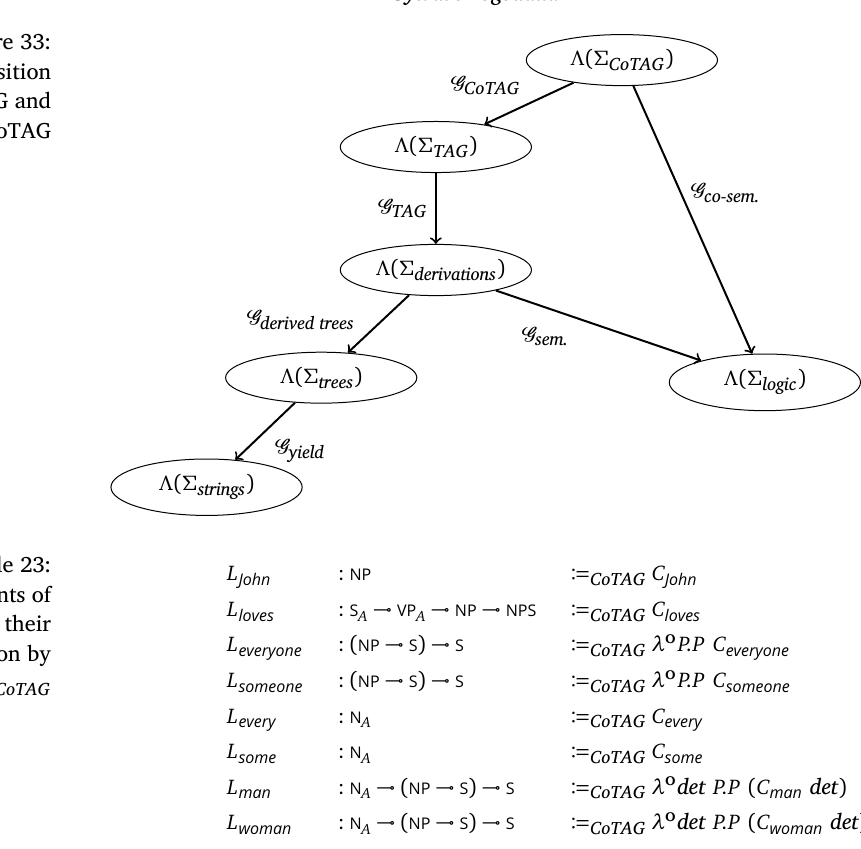
Constants of (cid:6) CoTAG and their interpretation by